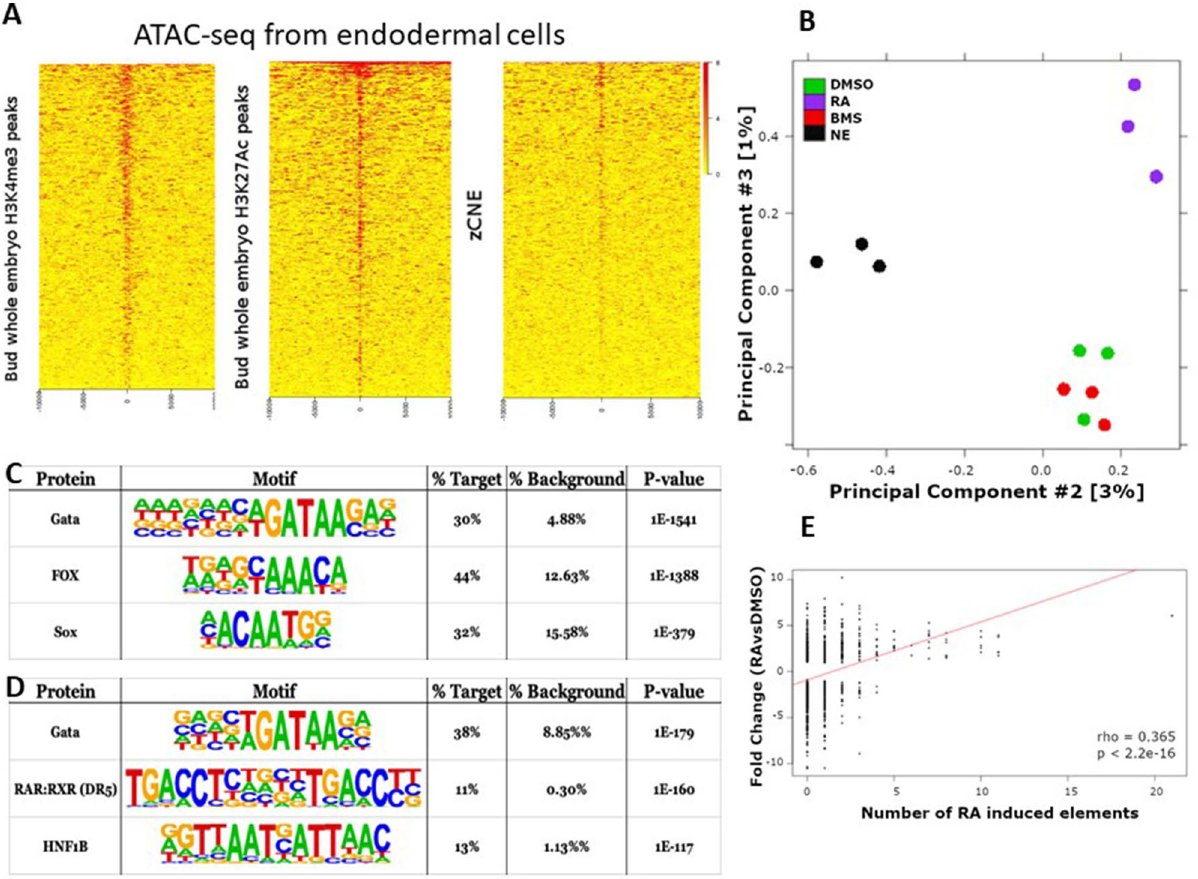
Figure 6. Identification of nucleosome-free regions in zebrafish endodermal cells and following RA treatments by ATAC-seq assays. ( A ) Heat maps showing enrichment of ATAC-seq reads at the middle of chromatin regions harbouring H3K4me3 and H3K27Ac epigenetic marks and at genomic areas corresponding to zCNE. The maps display intervals flanking 10 kb up and downstream of the features. The heat map plots shown on this figure corresponds to the ATAC-seq data obtained with control endodermal cells (DMSO-treated). Similar results were obtained for the other samples (see Suppl. Fig. 4). ( B ) PCA plots obtained for the ATAC-seq libraries. ATAC-seq data from endodermal and non-endodermal cells are separated along the PC2 axis, while those from RA-treated versus control and BMS493 are separated along the PC3 axis. The plot shows clustering of triplicates and no obvious separation of the DMSO- and BMS493- treated cells. ( C , D ) Top 3 enriched motifs found in nucleosome-free regions detected specifically in endoderm ( C ) and detected following RA-treatments ( D ). ( E ) Plot showing the correlation of RA-induced gene expression (log2 fold change) and the number of RA-induced nucleosome-free elements located nearby the genes. Only genes showing significant RA gene induction were regions upon RA/BMS493 treatments reveals that, in addition to RAR, Gata and Hnf1b factors are the major transcription factors driving the increase in chromatin accessibility at numerous regulatory regions in endoder- mal cells. All together, these data indicate that Gata6 and Hnf1ba, which are directly regulated by RAR, activate in a second step the expression of many genes. Previous studies on Xenopus embryos showed the role of Ndrg1, Hnf1b and Fzd4 downstream of RA signalling for the specification of pancreatic field 18, 26 . Our study confirms the conserved role of hnf1ba in zebrafish endoderm; in contrast, the zebrafish fzd4 ortholog was not found to be regulated by RA in endoderm nor other fzd paralogs. As for the zebrafish ndrg1a gene, it is induced by RA in zebrafish embryos but does not harbour any RAR site in its genomic loci revealing an indirect regulation by RA signalling in zebrafish. The treatment of embryos with exogenous RA leads to a similar number of up- and down-regulated genes; in contrast the treatment with the pan-RAR inverse-agonist BMS493 mostly causes down-regulation of genes. Such difference can be explained by the mode of action of BMS493 which stabilizes the association of RAR with its co-repressors NcoR/Smrt 38 . In contrast, RA causes mainly a release of co-repressors and the recruitment of co-activators. Most RA-downregulated genes detected in the present study likely represent indirect RAR targets such as genes expressed in anterior endodermal cells whose fate is modified upon RA treatment. This could be the case for the nkx2.1 , nkx2.3, nkx2.7 and tbx1 genes known to be expressed in the anterior endoderm and which are downregulated upon RA treatment and do not contain any RAR site in their genomic loci. We also observed